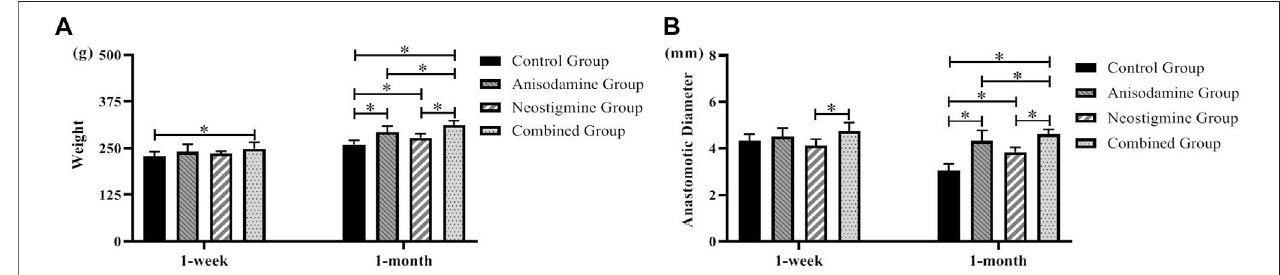
FIGURE 2 | Changes of liver function in rats at different time points after the RCJS procedure (* refers to the comparison between the two groups, p < 0.05). Comparison of (A) ALT (U/L), (B) AST (U/L), (C) TB (µmol/L), (D) DB (µmol/L), and (E) GGT (U/L) at different time points in rats of each group.